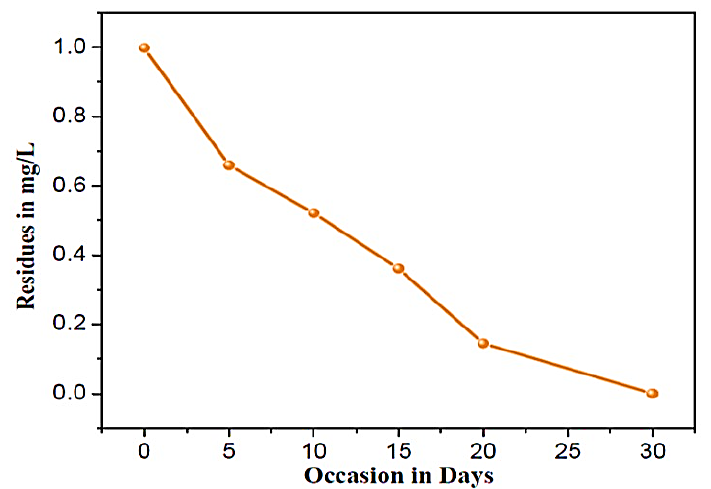
Figure 9. Graph representing the dissipation curve of photolytic decontamination of mancozeb in water under direct sunlight.